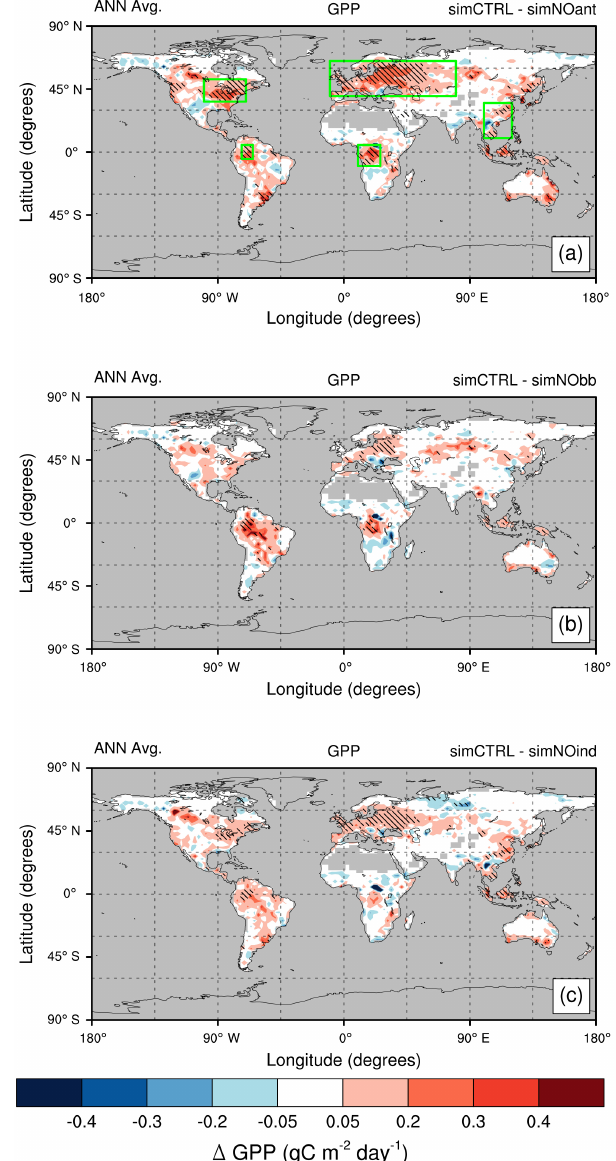
Figure 6. Spatial distribution of annual absolute change in gross primary productivity (GPP, in gCm − 2 day − 1 ) between the control experiment (SimCTRL) and sensitivity experiments: (a) without all anthropogenic emissions (SimNOant); (b) without biomass burn- ing emissions (SimNObb); and (c) without anthropogenic emissions except biomass burning (SimNOind). All experiments are set in a present-day climatic state. Shaded regions indicate areas where changes in GPP are significant at the 95% confidence level. Green boxes on plot (a) highlight key regions selected for discussion.